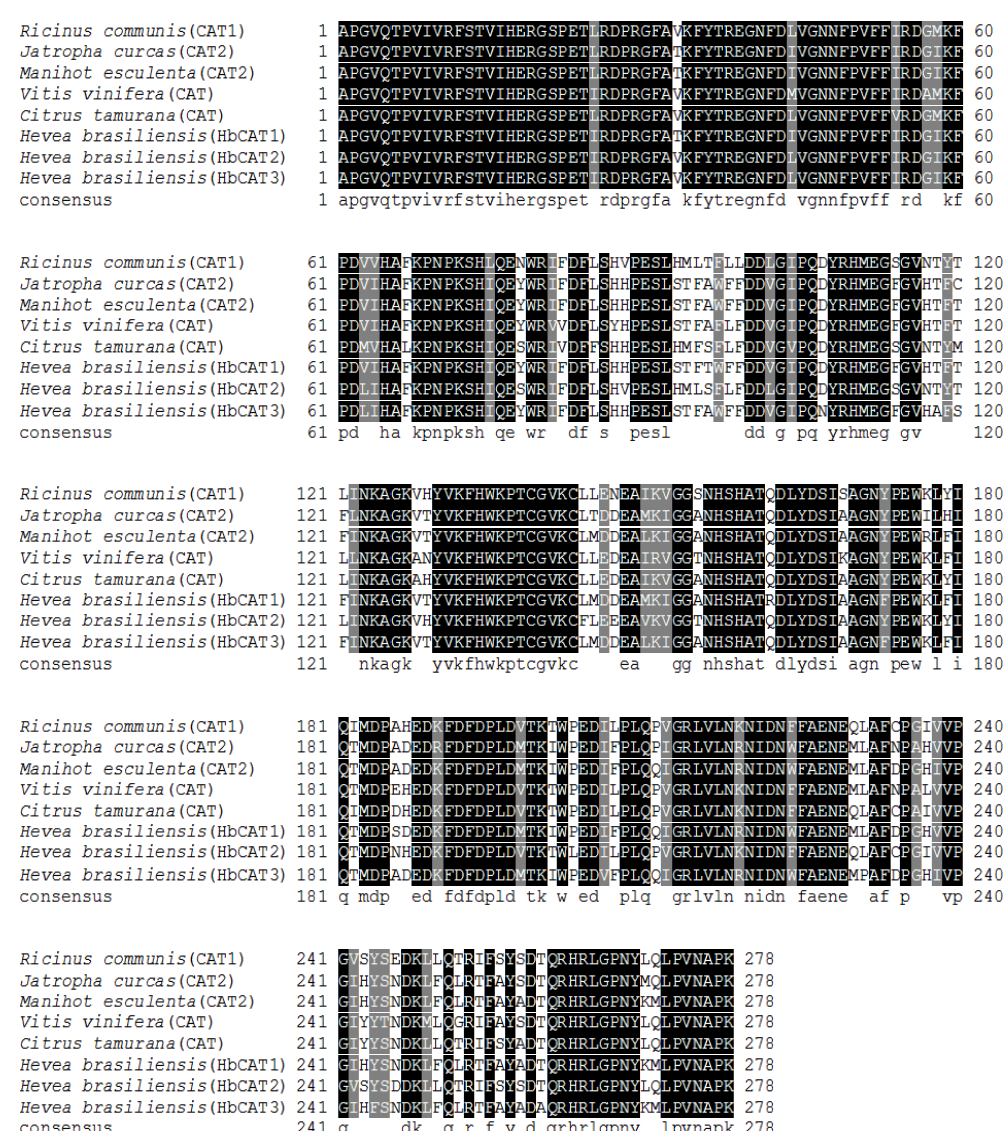
Figure 6. Multiple alignment of the deduced amino acid of HbCAT1, HbCAT2 and HbCAT3 with catalases from other plants, R. communis (BAA04697), J. curcas (NP_00129295.1), M. esculenta (AAD50974.1), V. vinifera (NP_001268098.1) and C. tamurana (BAQ21275.1). The conserved amino acid residues are shaded dark and the highly conserved amino residues are shaded grey.